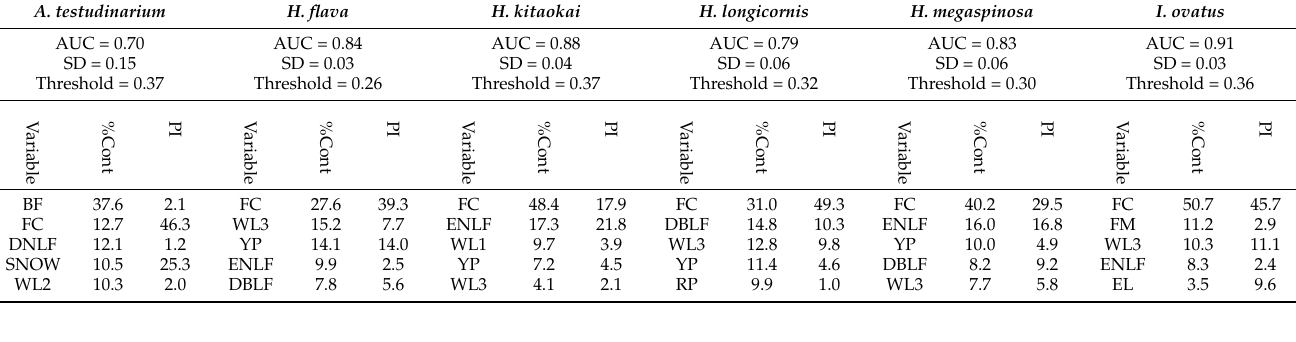
Figure 3. Potential distribution maps of A. testudinarium ( A ), H. flava ( B ), H. kitaokai ( C ), H. longicornis ( D ), H. megaspinosa ( E ), and I. ovatus ( F ). Red indicates a more suitable environment, and green indicates a less suitable environment for tick species. Table 2. MaxEnt modeling results (AUC, SD, and Threshold), percentage contribution (%Cont), and permutation importance (PI) for each variable calculated in the jackknife test. The thresholds indicate the logistic output for which the species is estimated as being absent in the 1-km 2 geographical mesh.